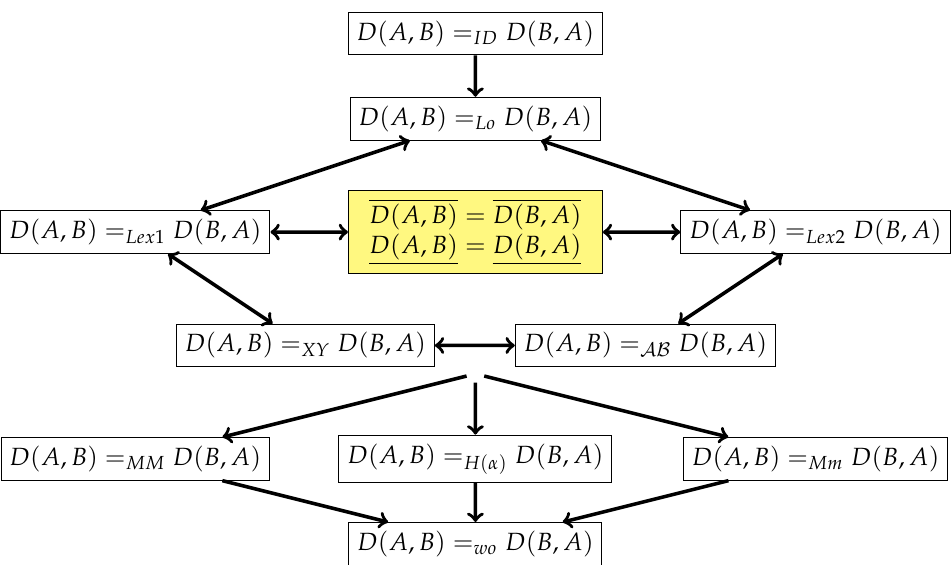
Figure 12. Symmetry for different